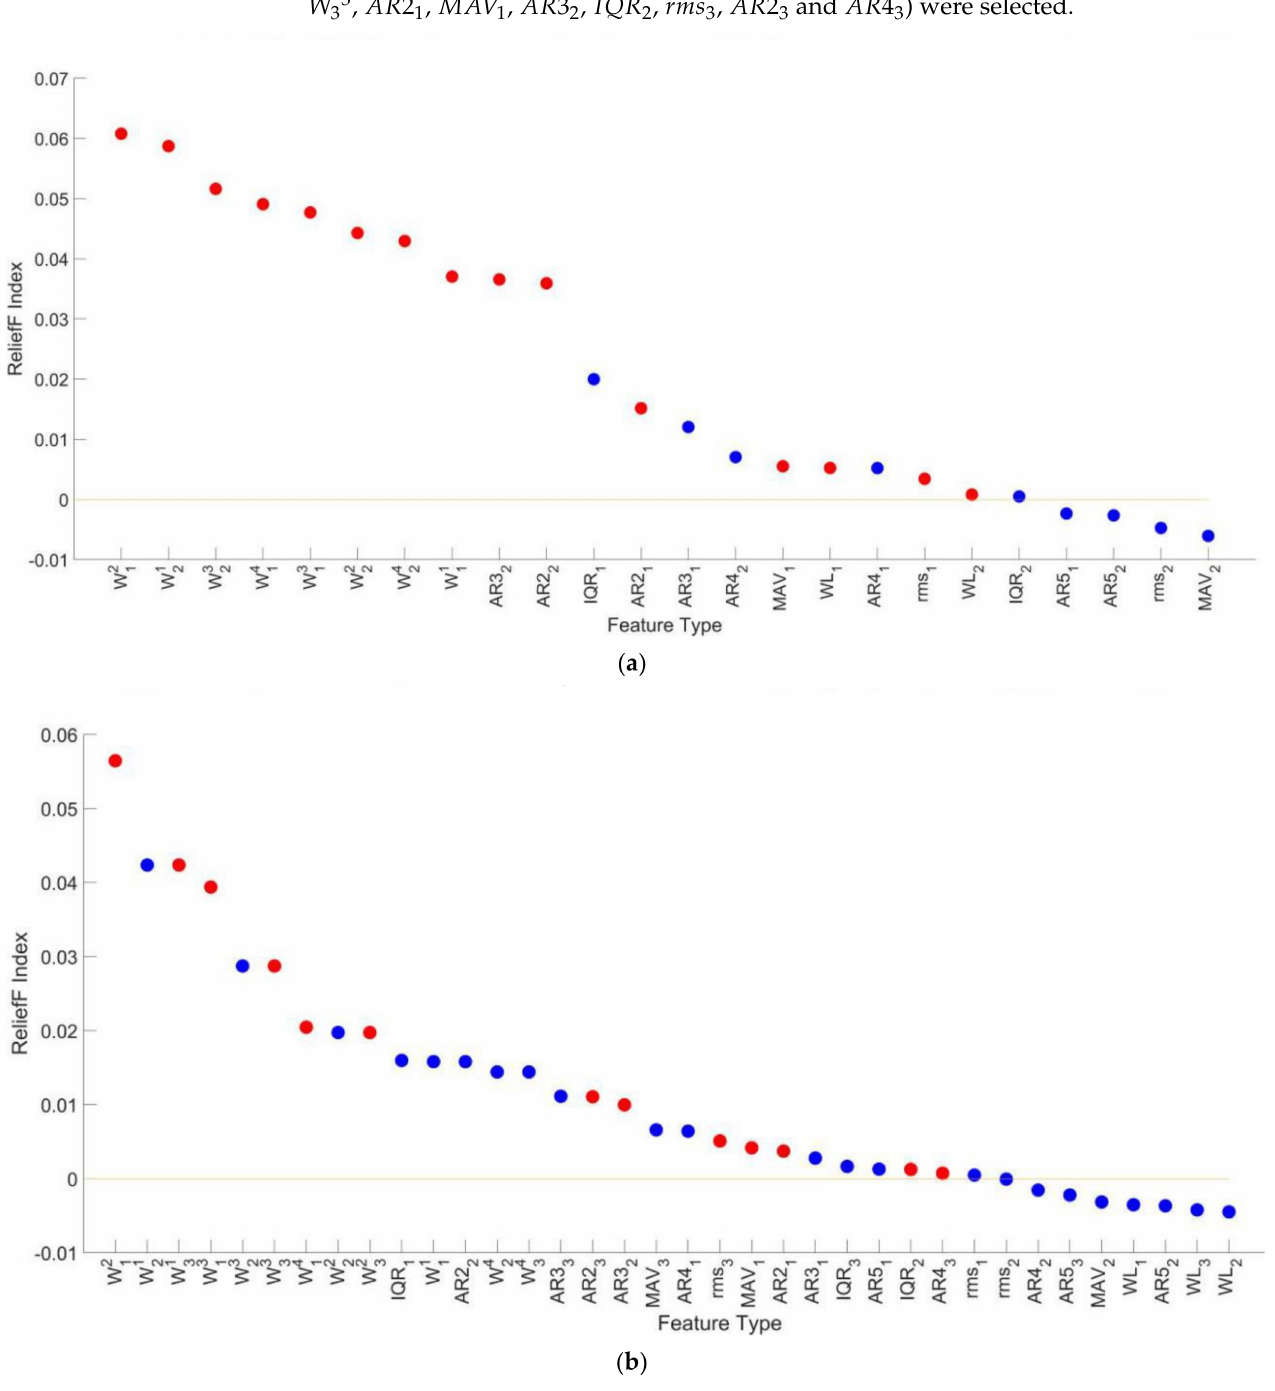
Figure 8. The Relief F Index of all features in the fine feature sets and features (the red scatters) selected by the feature selection method in different synergy numbers. ( a ) k = 2 and ( b ) k = 3. The blue scatters represent features that are not selected by the feature selection